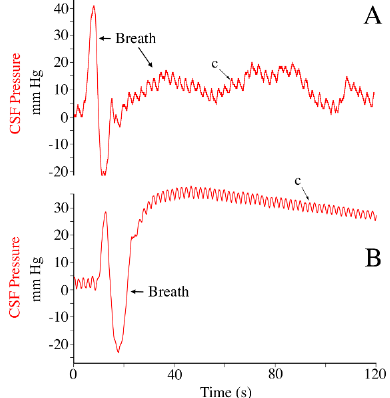
Figure 9. Impact of active breathing on CSF pressure. Pressure traces from two specimens of Alligator mississippiensis recorded during the locomotor trials (post-recovery) show the marked change in CSF pressure (red) during active breathing. One alligator ( A ) performed a deep active breath followed by two shallow breaths (the latter similar to those induced by the ventilator). The second alligator ( B ) performed a deep active breath then entered a period of apnea with sustained elevated CSF pressure. c—individual cardiac-related pulsation.